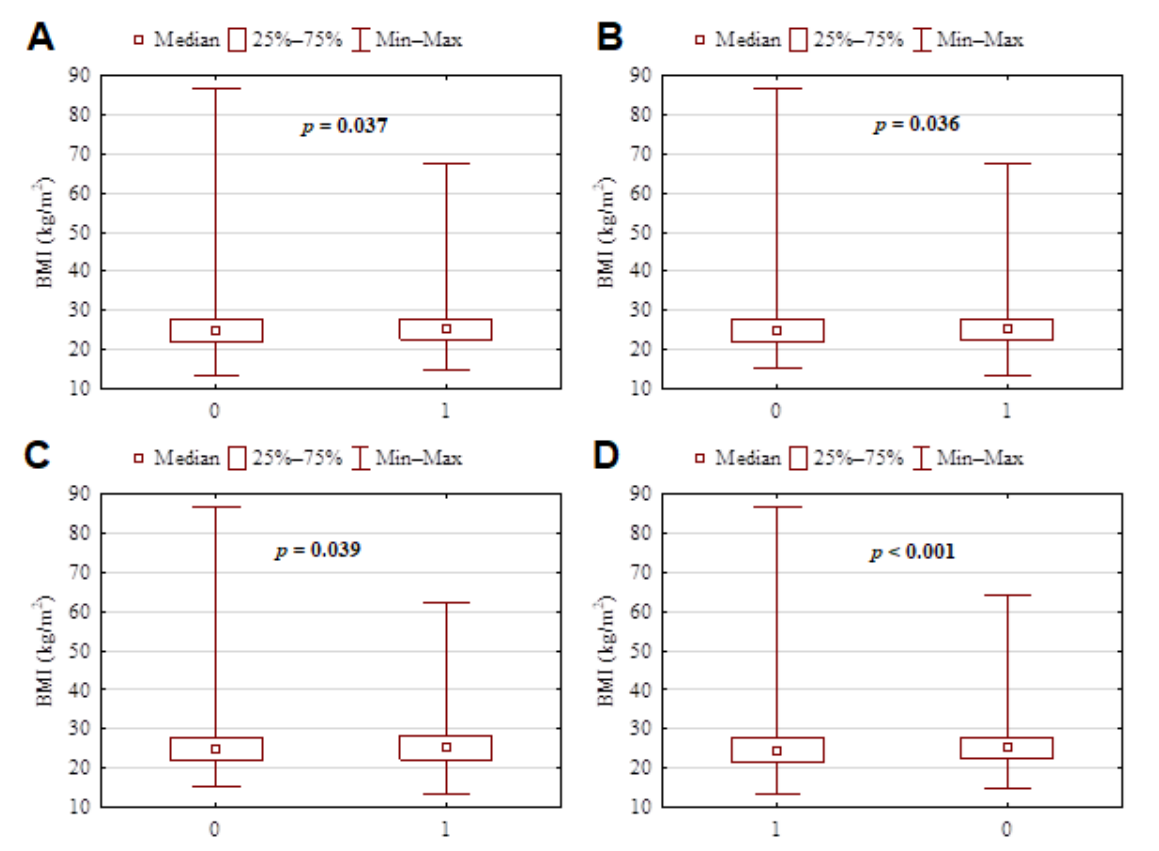
Figure 3. Questionnaire significant results according to BMI of subjects. ( A ) Difficulty in scheduling a dental visit was significantly greater among subjects affected from overweight. 0—no, 1—yes ( p = 0.037). ( B ) In the first period of pandemic time to schedule for a dental examination or any invasive dental treatment, dental anxiety and fear were significantly greater among people characterized by